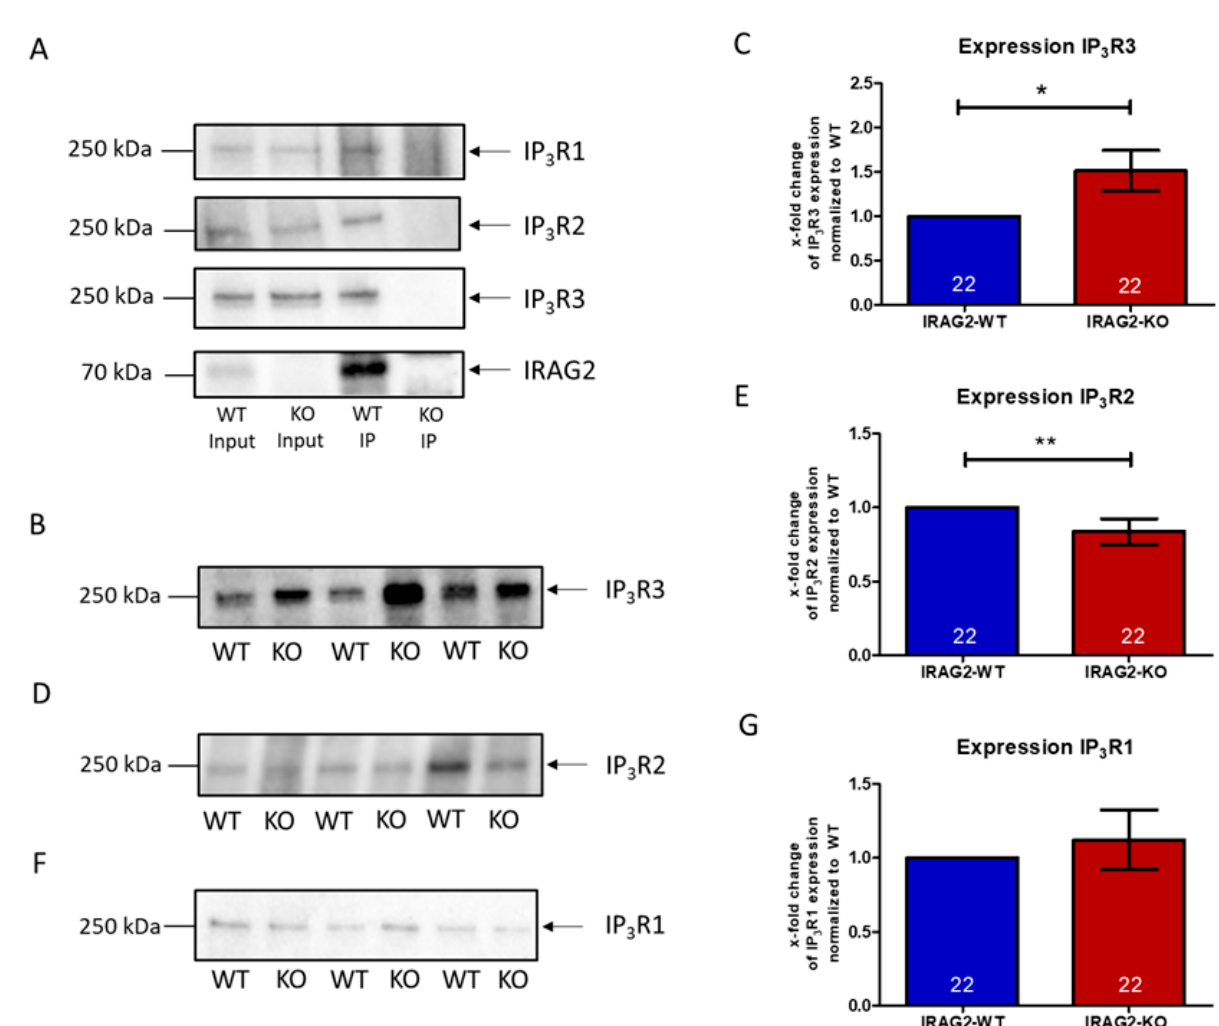
Figure 2. Interaction of IRAG2 with IP 3 receptor types 1, 2, and 3 ( A ) and expression of different IP 3 receptors in pancreata from IRAG2-WT (WT) and IRAG2-KO mice (KO) ( B – G ). ( A ) After coimmunoprecipitation of pancreas lysates from IRAG2-KO (KO) and IRAG2-WT (WT) mice with IRAG2 antibody (1 µg), proteins were detected by Western blot. For coimmunoprecipitation, 1500 µg and for input 70 µg protein was used. ( B , D , F ) Protein expression of IP 3 R3, IP 3 R2, and IP 3 R1 was analyzed by Western blot and normalized to total protein (TP) for quantification. ( B , C ) Representative Western blot of IP 3 R3 showed a significant increase of IP 3 R3 expression in pancreata of IRAG2-KO (KO) mice compared to IRAG2-WT (WT) mice. ( D , E ) Analysis of IP 3 R2 showed a significant decrease of IP 3 R2 expression in IRAG2-KO (KO) compared to IRAG2-WT (WT). ( F , G ) IP 3 R1 expression was not altered between IRAG2-WT (WT) and IRAG2-KO (KO). ( C , E , G ) Statistical analysis of the different IP 3 receptors ( B , D , F ). Results are given as x-fold change of expression normalized to IRAG2-WT. Images of total protein (TP) are shown in Figure S5. Numbers of analyzed lysates are indicated in the graphs, and the mean ± SEM is shown by bars. Significant differences are indicated by (*) ( p < 0.05) and (**) ( p <